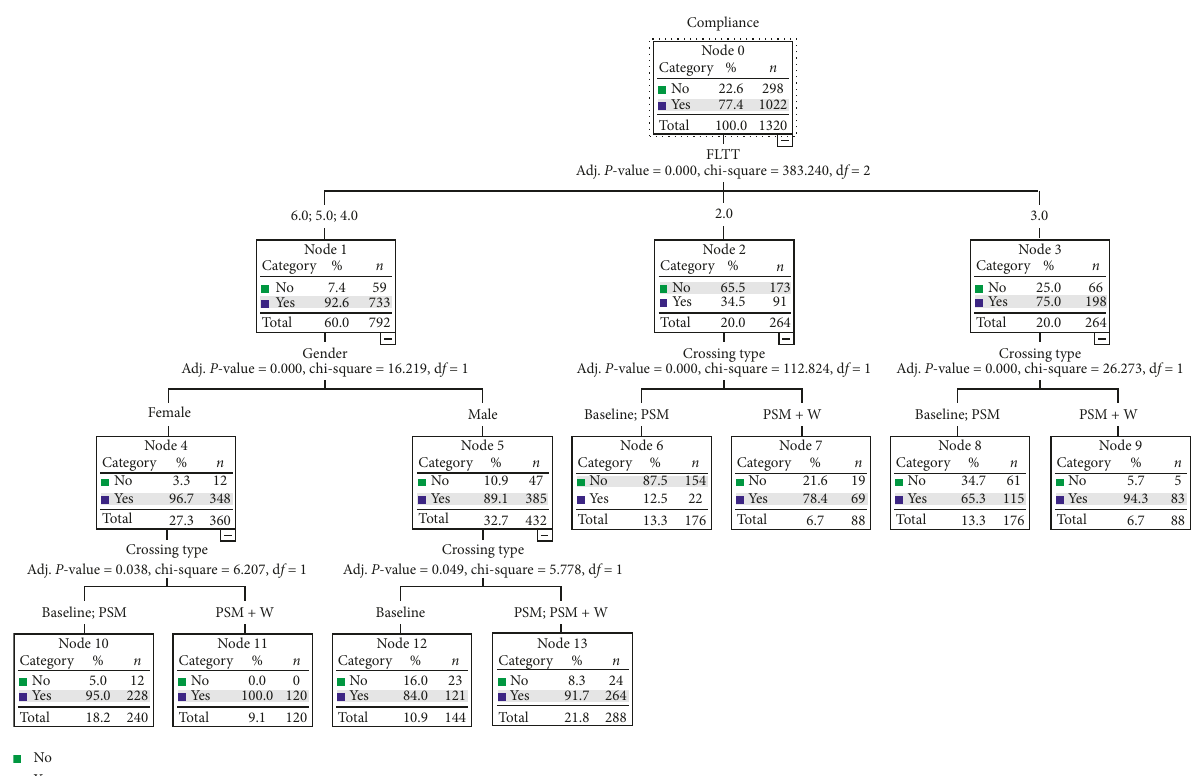
Figure 6: Hierarchical tree-based regression (HTBR) model: predicting drivers’ compliance within different categories of